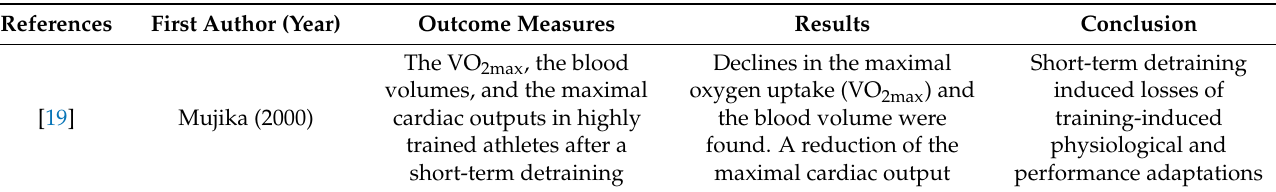
Table 3. Physical and physiological impacts of training cessation in